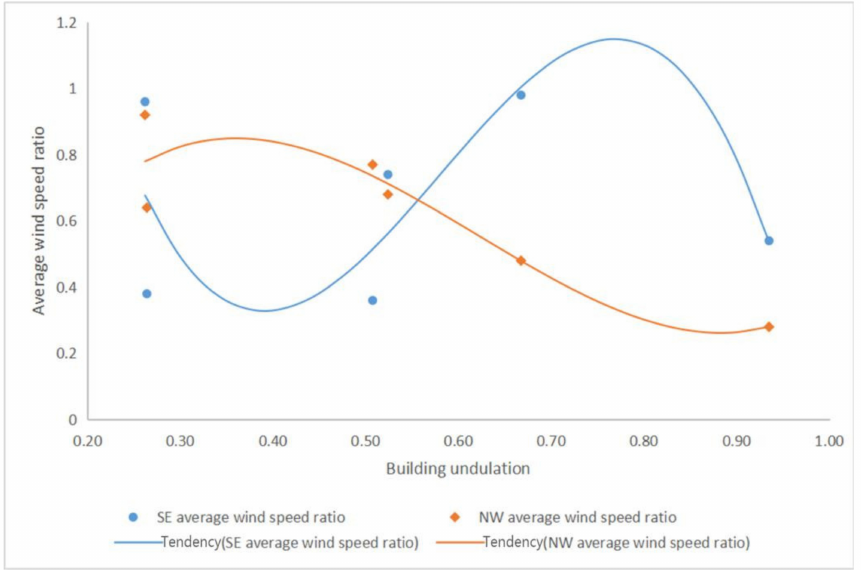
Figure 21. The relationship between the average wind speed ratio and building undulation. For the curves, when the two curves intersected at x = 0.25, 0.56, and 0.95, the winter to summer average wind speed ratio was equal. The inflection points of the southeast wind curve appeared at x = 0.39 and x = 0.77, corresponding to a minimum point of y = 0.33 and a maximum point of y = 1.15 for the average wind speed ratio. The two inflection points for the northwest wind were x = 0.88 and x = 0.36, corresponding to y values of 0.26 and 0.85. While the comfort interval requirement of (0.50, 2.00) was ensured to be met, the values of the building undulation x for the two curves were taken to be in the range of [0.13, 0.30] ∪ [0.50, 0.93] for the southeast wind and [0.15, 0.65] ∪ [1.06, 1.30] for the northwest wind.